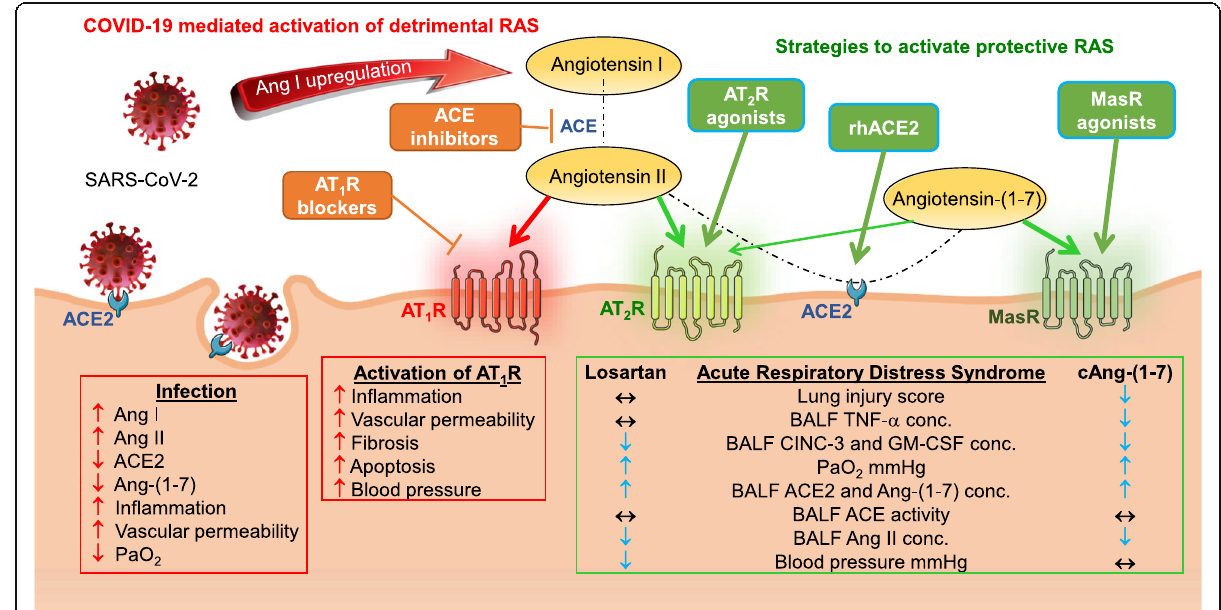
Fig. 1 Potential treatments of SARS-CoV-2 infection within the Renin Angiotensin System containing a summary of an animal model of acute respiratory distress syndrome (Wösten-van Asperen et al.